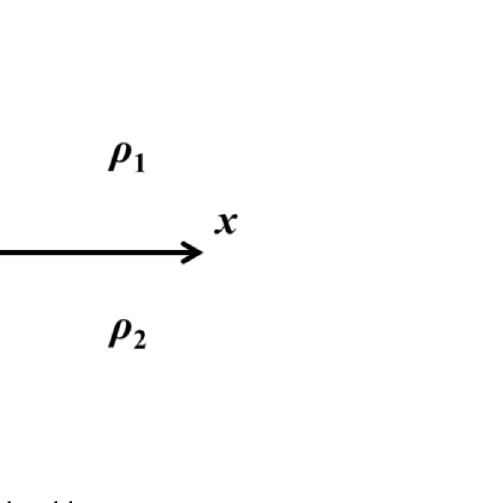
Figure 1. The schematic of the physical